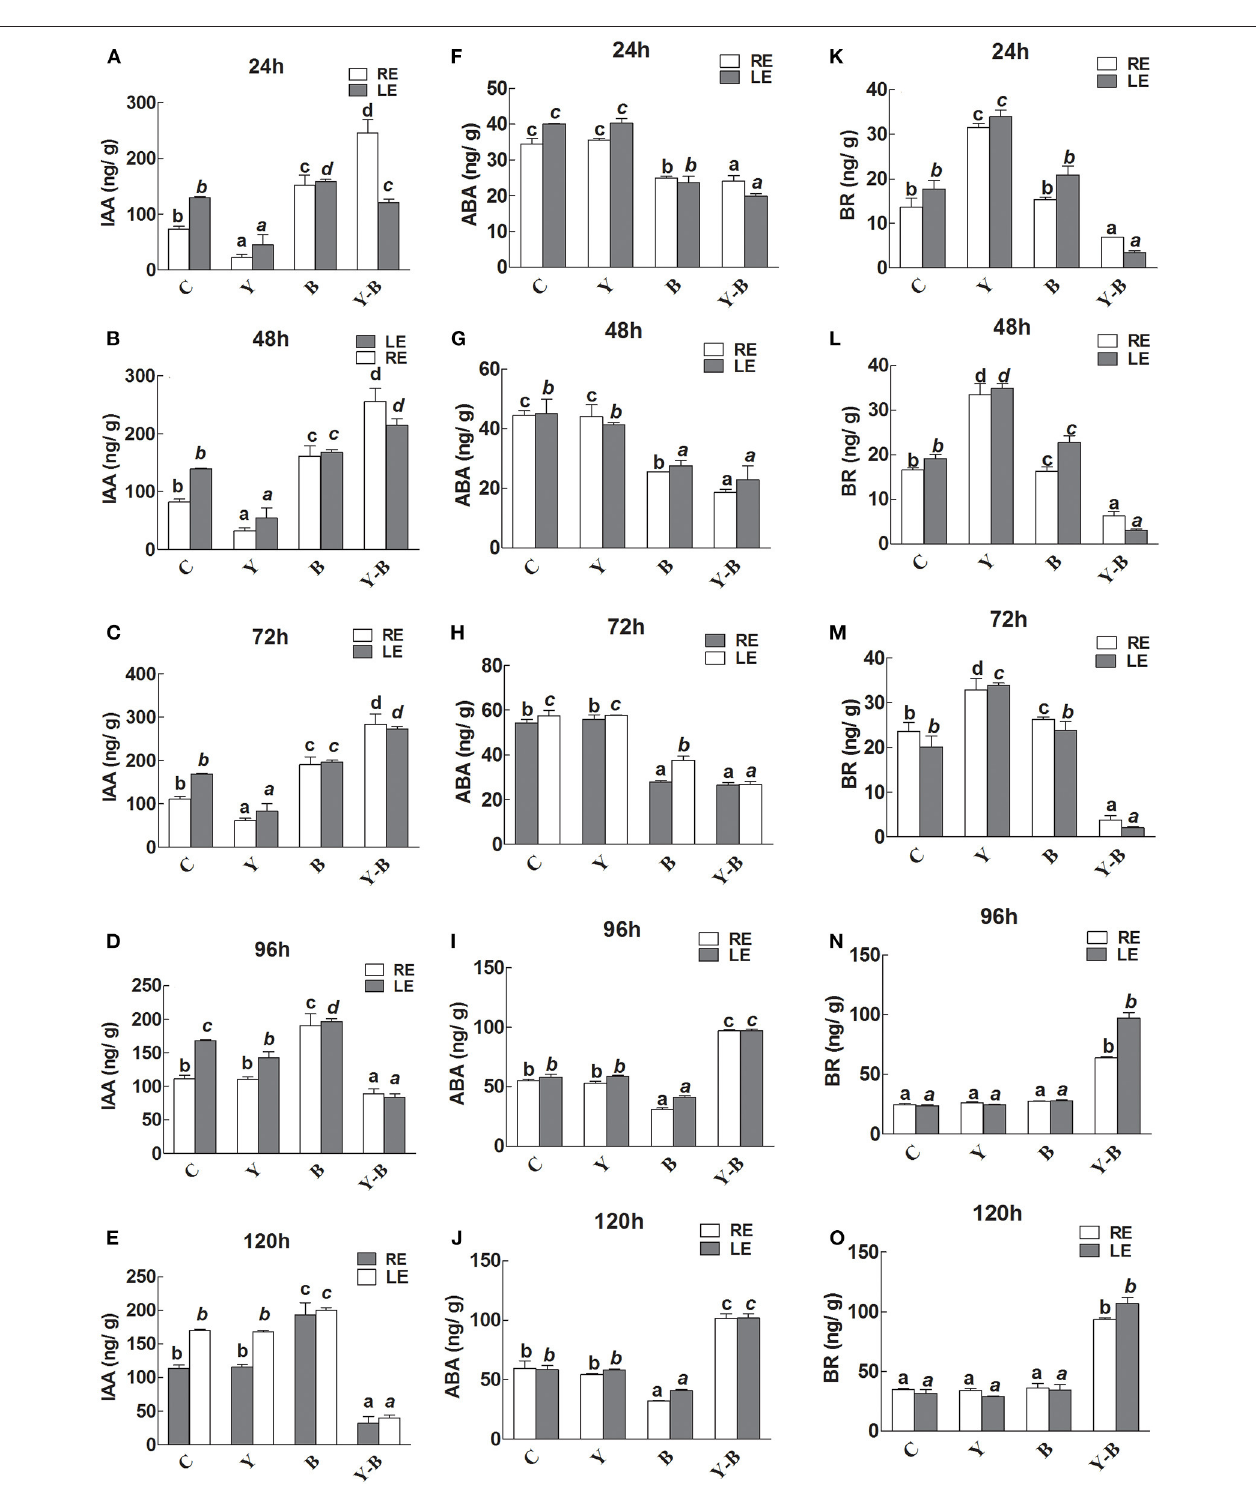
FIGURE 6 | Determination of IAA (A–E) , abscisic acid (ABA; F–J ), and brassinosteroids (BR; K–O ) in the leaf extracts (LE) and root exudates (RE) of 11-days-old maize seedlings exposed to different treatments, including C (control); Y (yucasin), B ( Bipolaris spp.), Y-B (yucasin- Bipolaris spp.) for the different time duration. Data are mean from three independent experiments with standard error bars. Bars labeled with different letters are significantly different (Duncan test; p < 0.05).